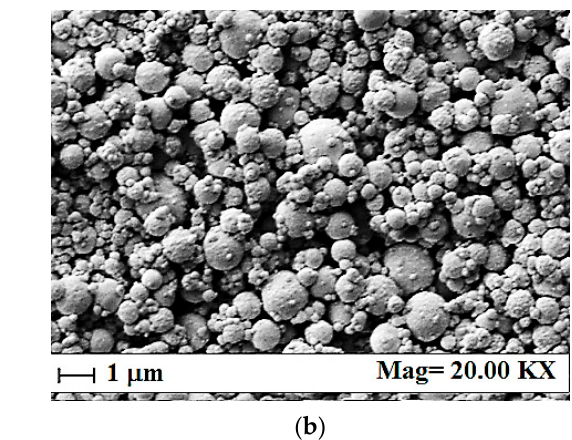
Figure 6. DSC analyses of sodium alginate (green) and salicylic acid (red) untreated powders, so- dium alginate and salicylic acid untreated powders mixed in a 1/4 weight ratio (black), and loaded microparticles produced via SAA (blue).